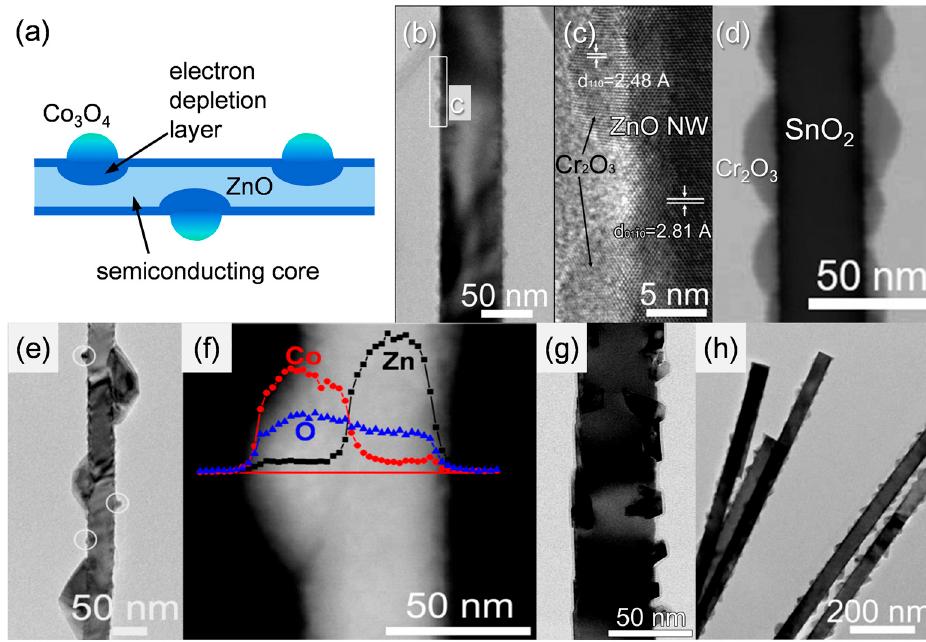
Figure 2. ( a ) Schematic diagram of the electron depletion layer in n -type oxide semiconductor nanowires decorated with p -type oxide semiconductor nanoclusters; TEM images of ( b , c ) Cr 2 O 3